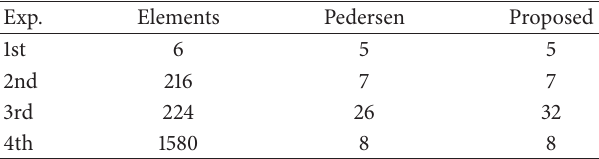
Table 11: Newton-Raphson iteration count to reach desired accu- racy (Pedersen: Pedersen’s nonlinear FEM; Proposed: proposed nonlinear